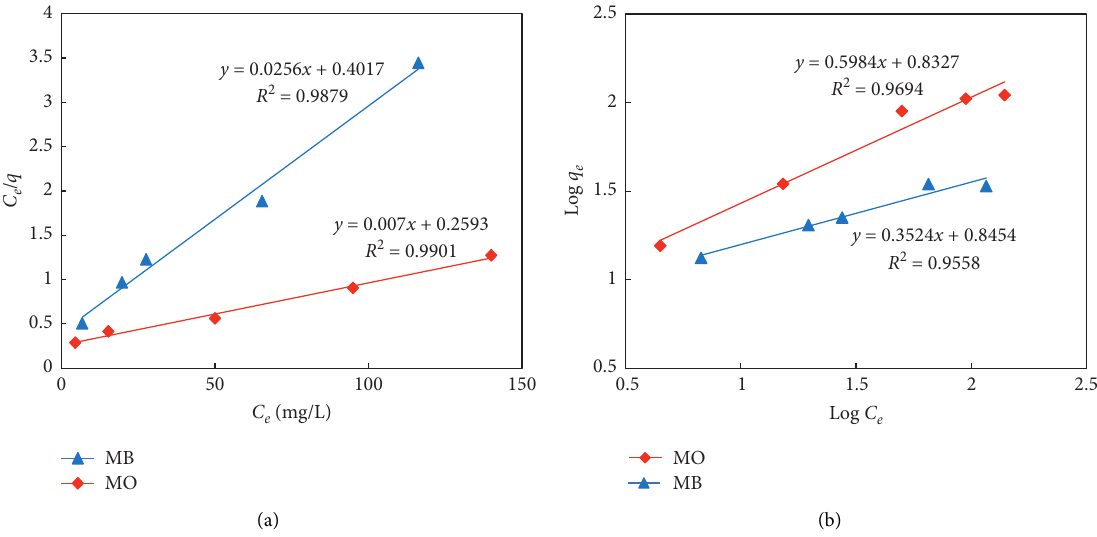
Figure 6: Linear isotherm models for the adsorption of MB and MO onto UiO-66-NO